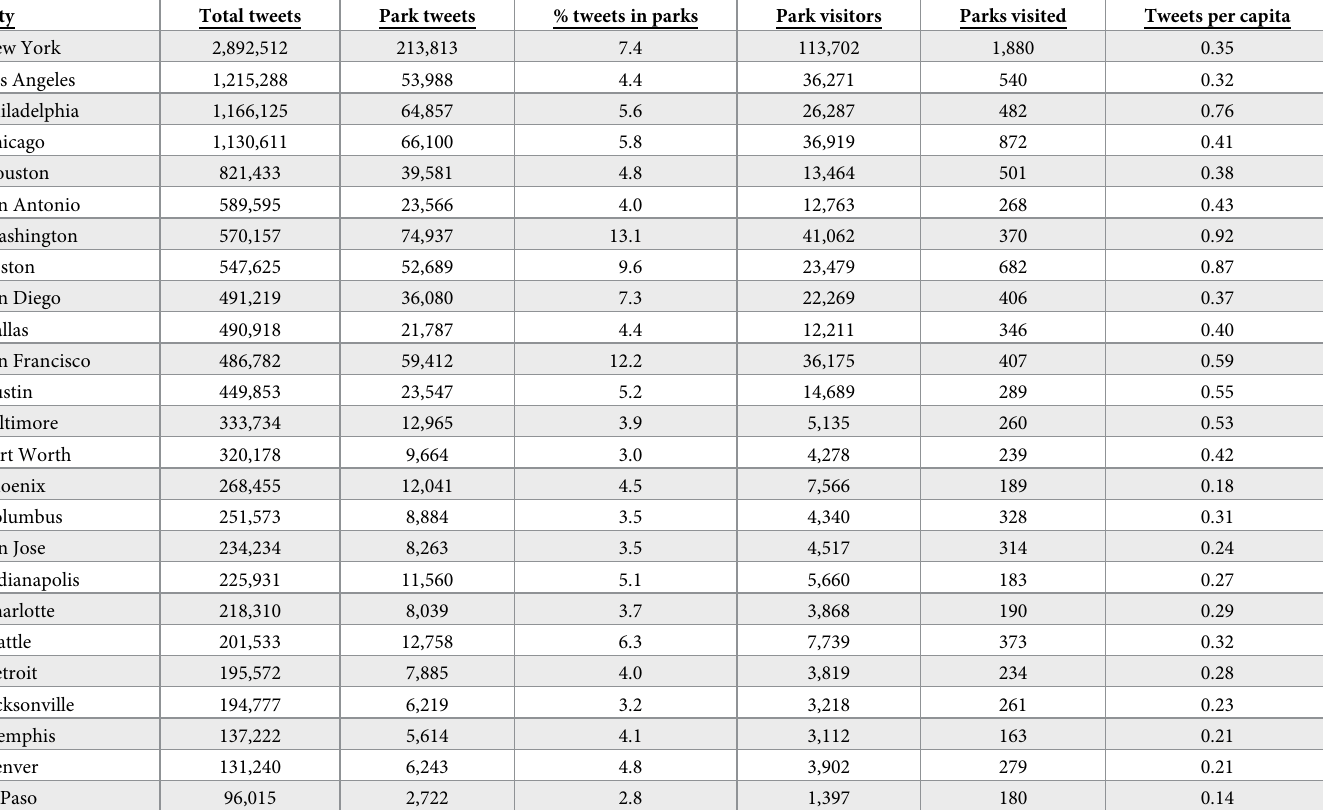
Table 1. Summary of geolocated Twitter data for the 25 most populous cities in the U.S. from 2012–2015. ‘Total tweets’ enumerates all public tweets posted from a GPS latitude/longitude inside that city. ‘Park tweets’ is the total number of tweets posted from inside parks. The ‘% tweets in park’ column calculates Park tweets / total Tweets. ‘Park visitors’ is the number of unique users who tweeted inside one of that city’s municipal park locations as defined by Trust for Public Land’s ParkServe. ‘Parks visited’ is the number of unique facilities from which a tweet was posted within that city. ‘Tweets per capita’ is number of total messages for the entire period divided by the city’s population in